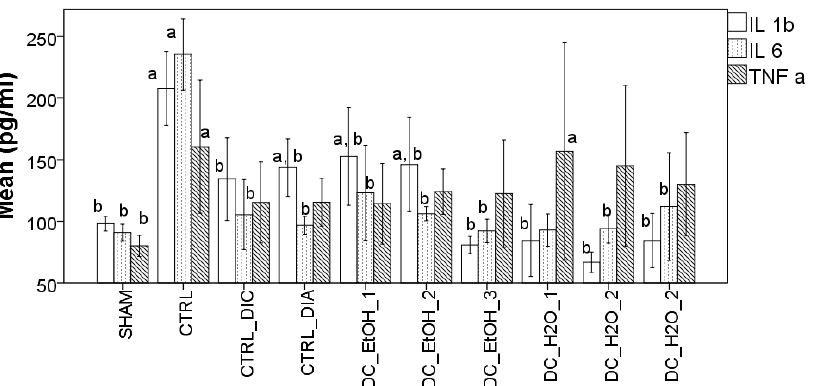
Figure 4. Effect of Dichrostachys cinerea fruit extracts on the inflammatory cytokines TNF- α , IL-1 β , and IL-6 in CFA-induced arthritic rats. Serum inflammatory cytokines values are expressed as mean ± standard error of the mean (n = 10). Superscript ‘a’ indicates a significant difference ( p < 0.05) as compared to the SHAM group while superscript ‘b’ indicates a significant difference ( p < 0.05) as compared to the CTRL group as performed by one-way ANOVA, Tukey’s multiple comparisons test.